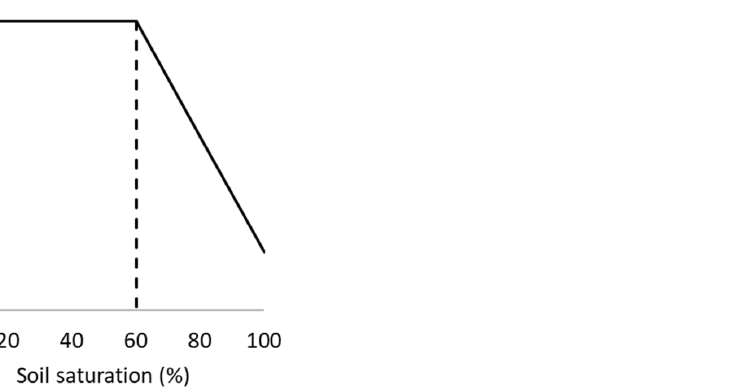
Figure 1 . APSIM waterlogging function with an inflection point (threshold value) of 60%.